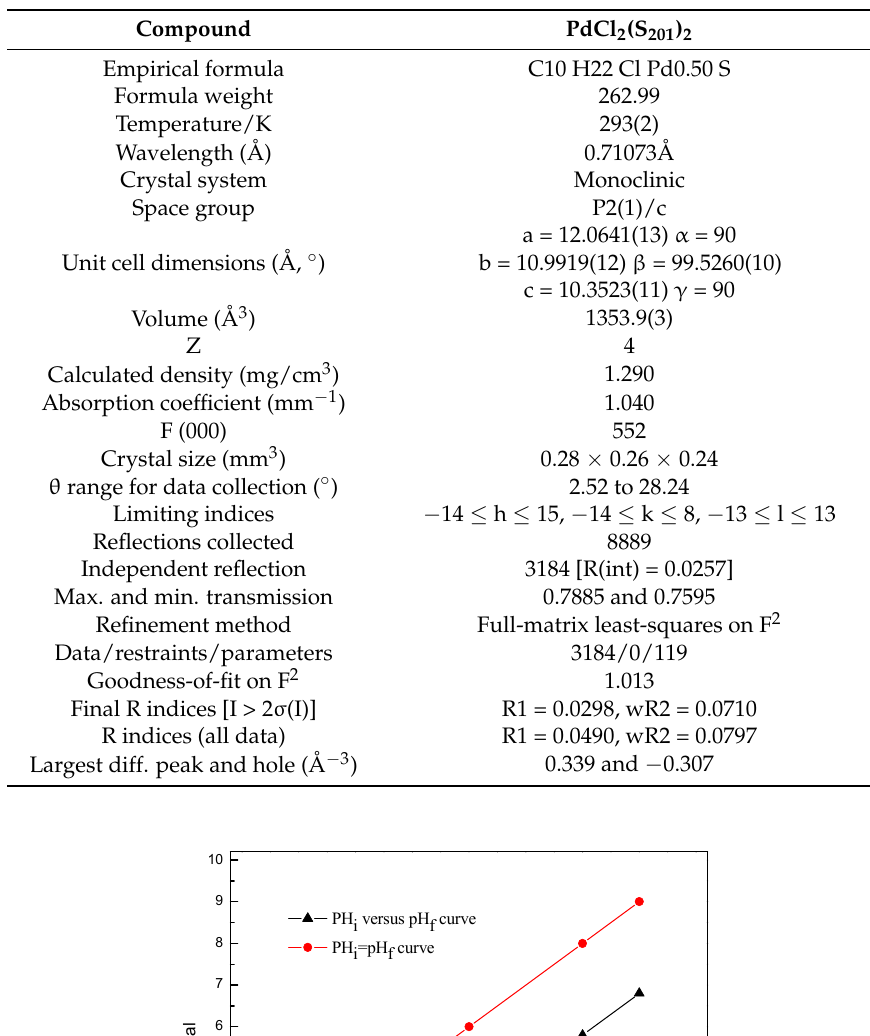
Table 6. Crystallographic data and refinement parameters for PdCl 2 (S 201 ) 2 .